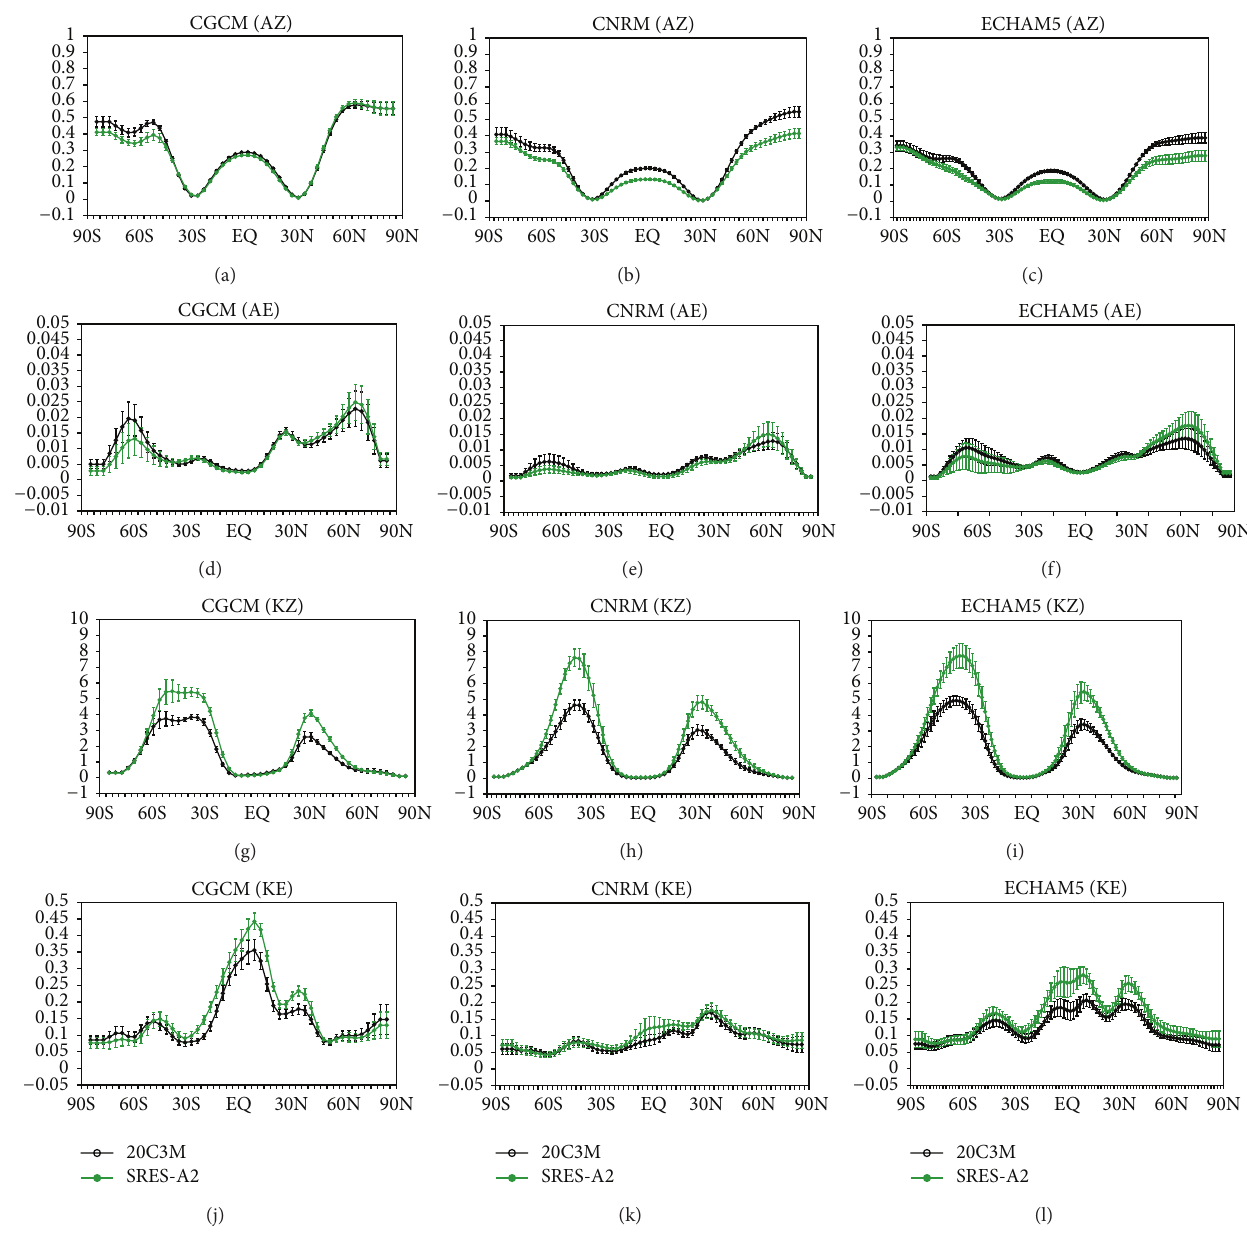
Figure 6: Annual latitudinal distribution of volume integrated of zonal available potential energy for CGCM (a), CNRM (b), and ECHAM5 (c), eddy available potential energy for CGCM (d), CNRM (e), and ECHAM5 (f), zonal kinetic energy for CGCM (g), CNRM (h), and ECHAM5 (i), and eddy kinetic energy for CGCM (j), CNRM (k), and ECHAM5 (l) models. Error bars indicate 95% confidence intervals about the mean. Units are 10 5 Jm −2